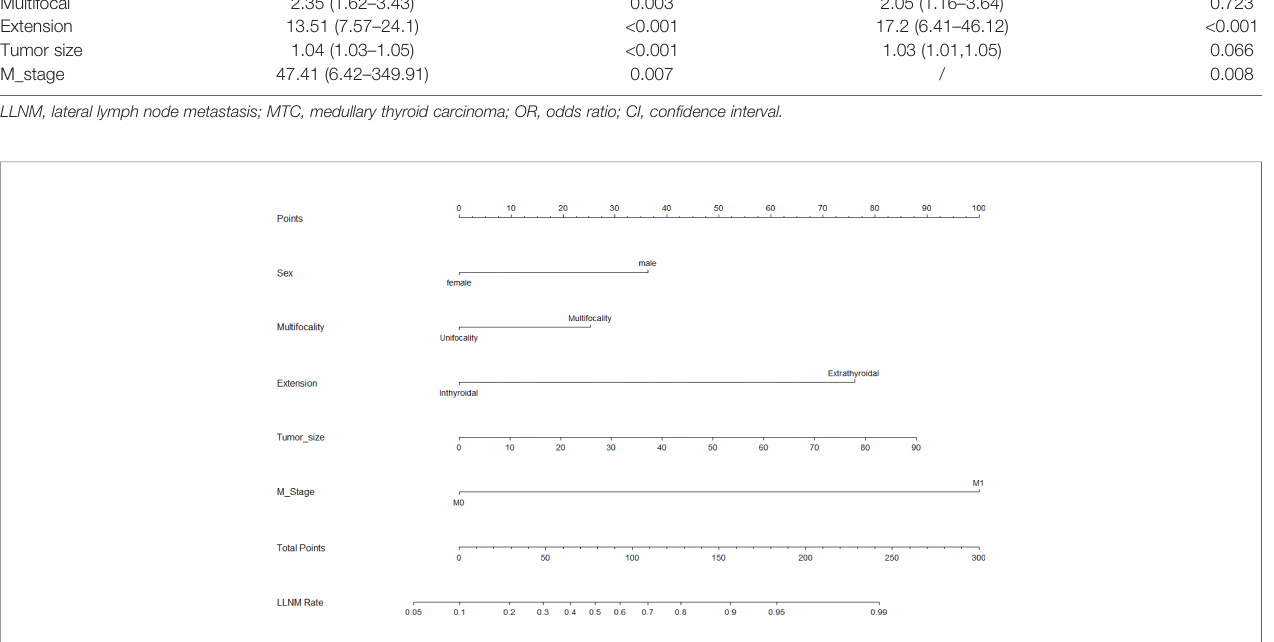
FIGURE 2 | Nomogram for predicting LLNM in MTC patients. LLNM, lateral lymph node